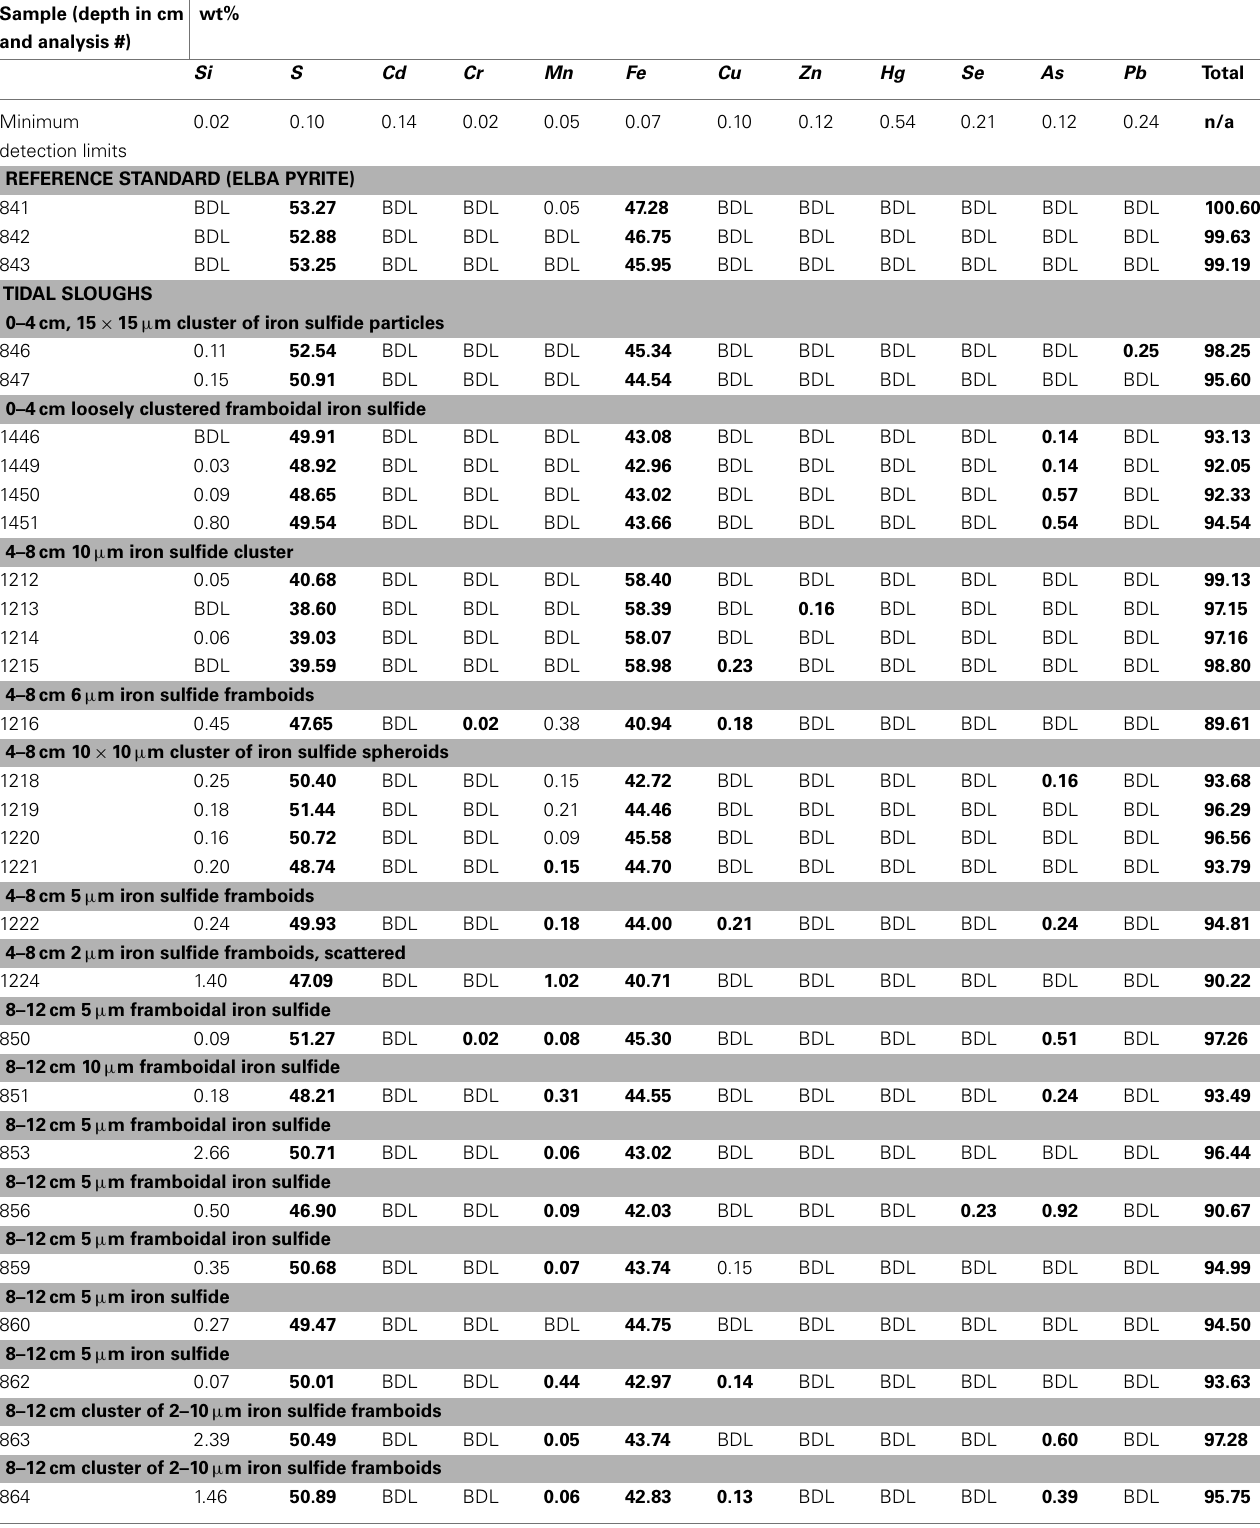
Table 2 | Concentrations of elements in metal-sulfides by electron microprobe